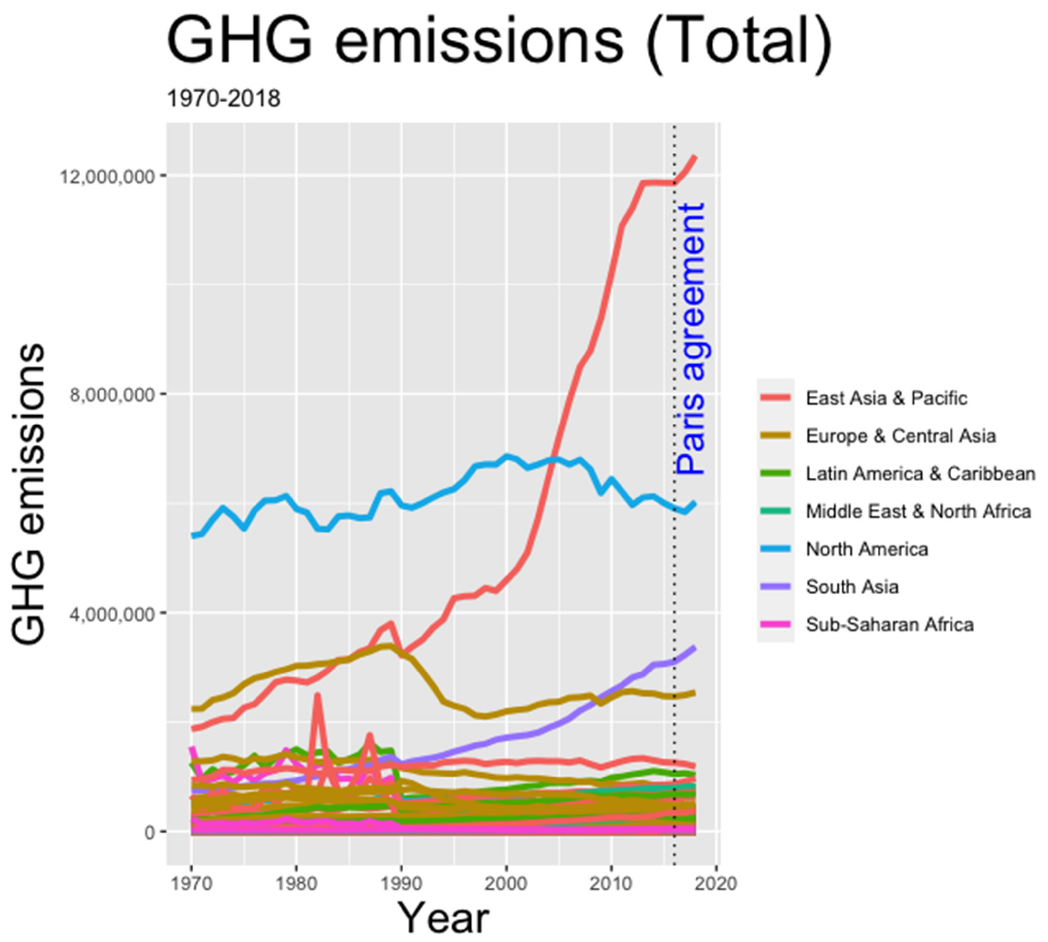
Figure 3. Historical trends of greenhouse gas emissions.